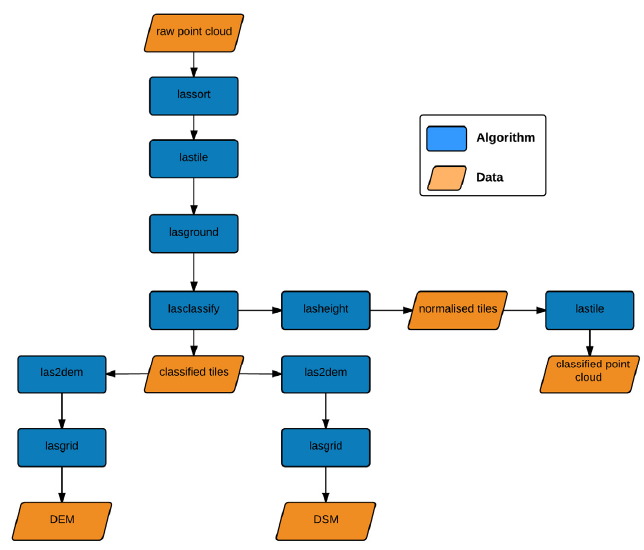
Figure 4. Summary of point cloud post-processing using LAStools. The commands were executed in a single batch script.